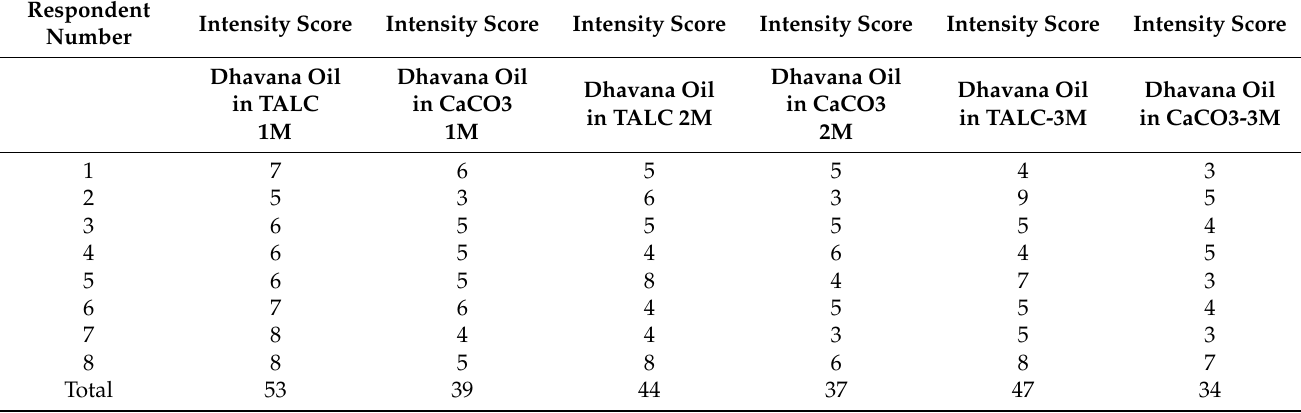
Table 9. Comparison of intensity scores of neat Dhavana oil in TALC and CaCO 3 after 1, 2